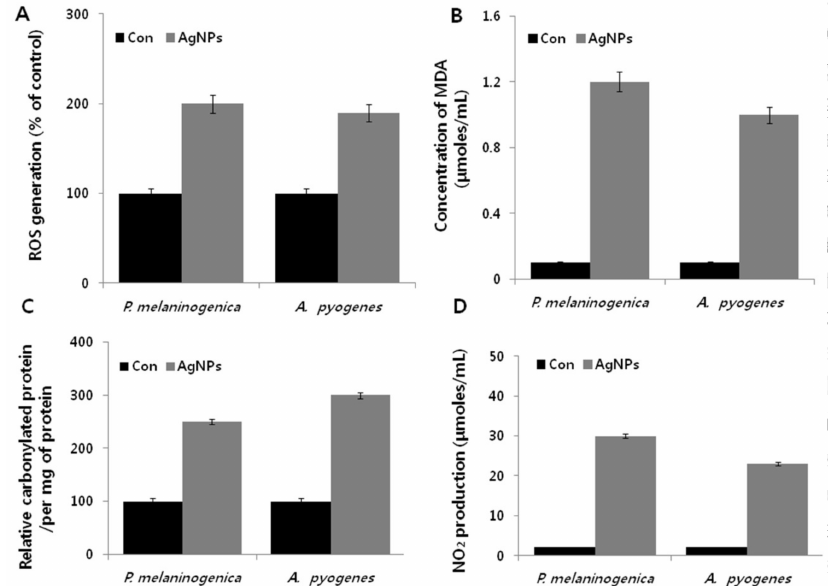
Figure 6. Effect of AgNPs on cellular toxicity in P. melaninogenica and A. pyogenes. ( A ) P. melaninogenica and A. pyogenes cells were treated with 0.8 and 1.0 µ g/mL of AgNPs respectively for 12 h. ROS generation was measured using DCFDA. ( B ) MDA levels were measured using a TBARS assay. ( C ) The relative protein carbonyl content was evaluated compared to the total protein content. ( D ) The quantity of NO was quantified spectrophotometrically using the Griess